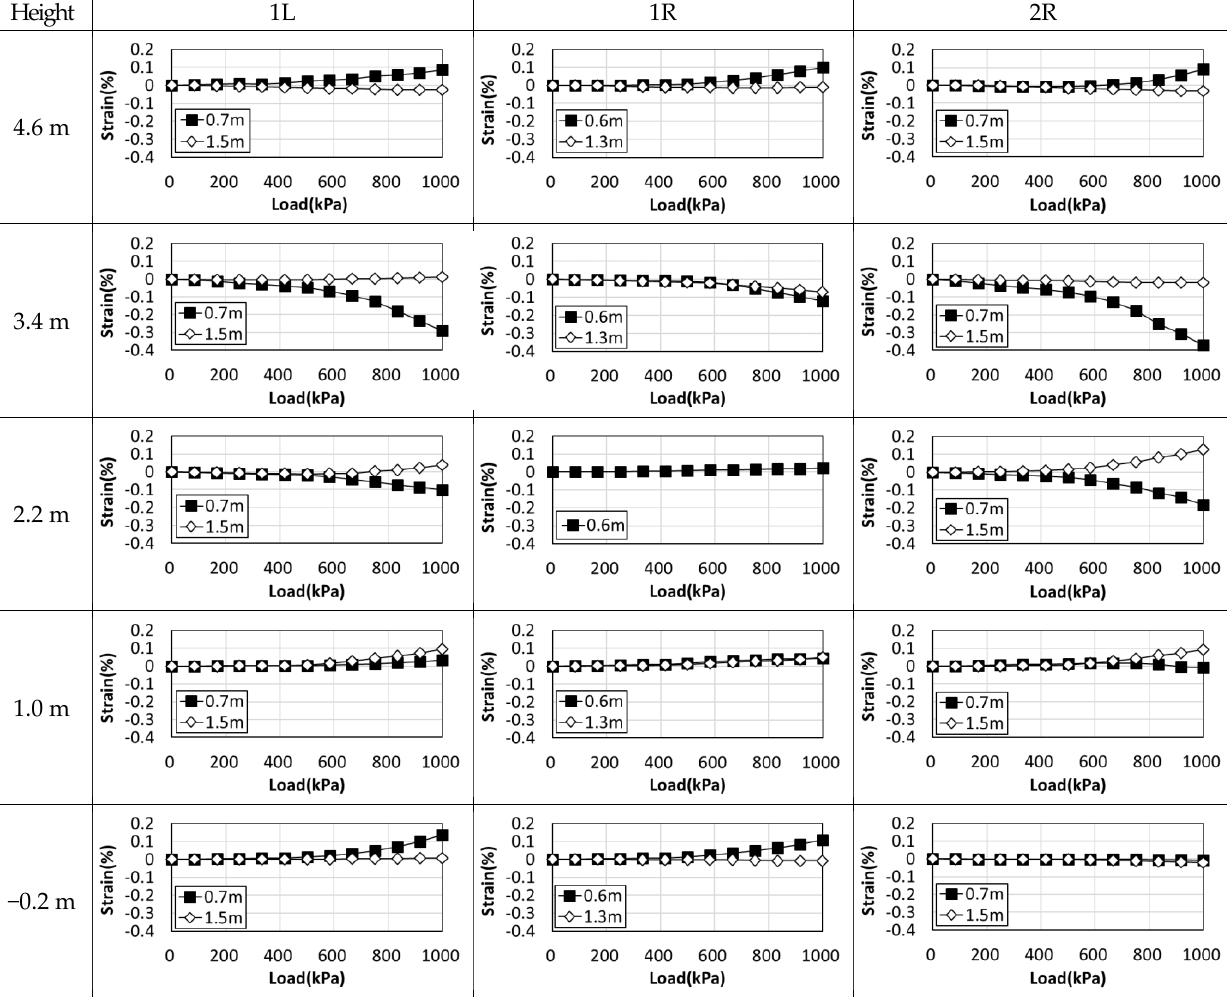
Figure 16. Reinforcement strain with respect to load.